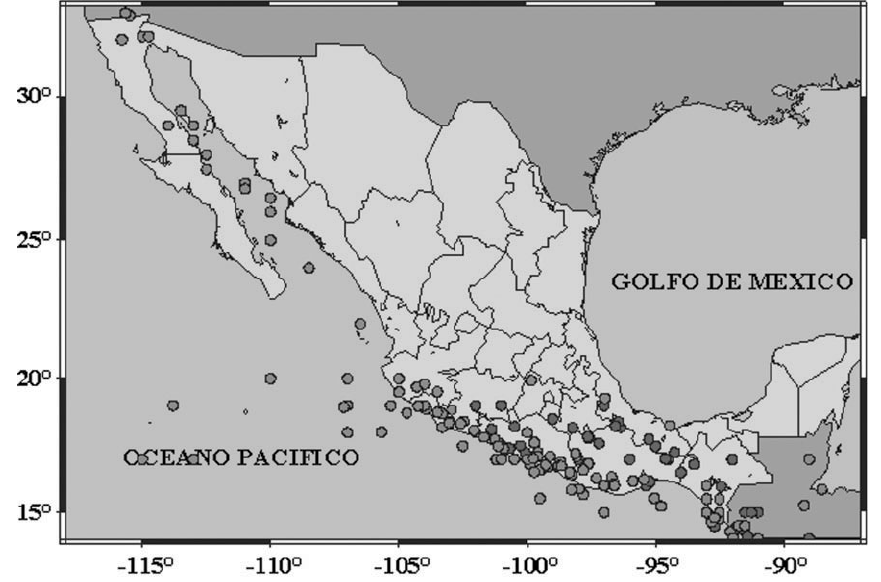
Fig. 1. 20th century Mexican earthquakes with M ≥ 6.5 (courtesy of Servicio Sismologico Nacional, Instituto de Geofisica, UNAM,